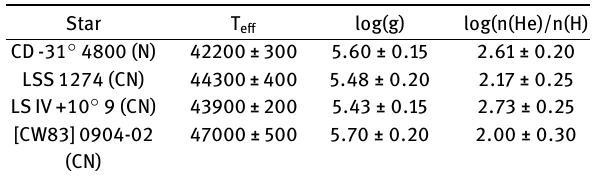
Table 2. Atmospheric parameters for the four sample stars, deter- mined from HHe+metal